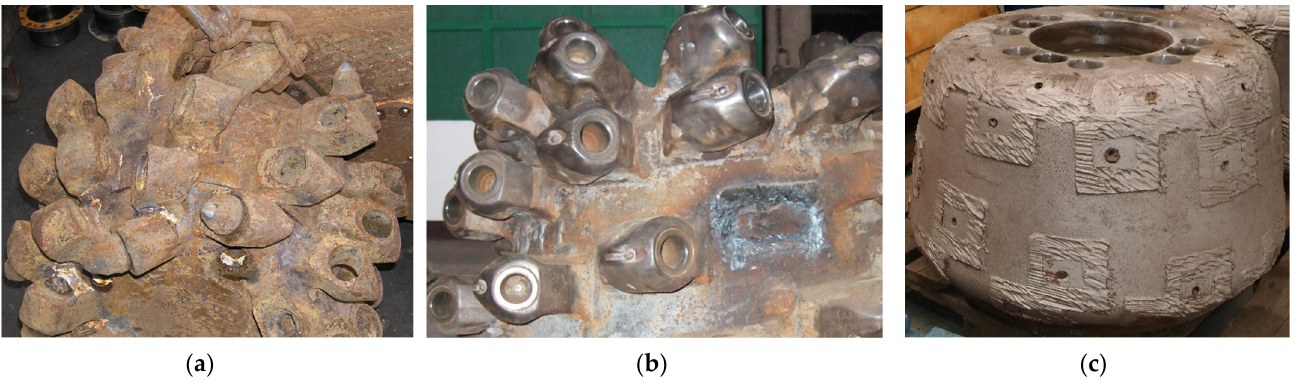
Figure 1. Roadheader’s extending heads: ( a ) decommissioned, ( b ) in the course of removing the pick holders, and ( c ) after removing the pick holders.